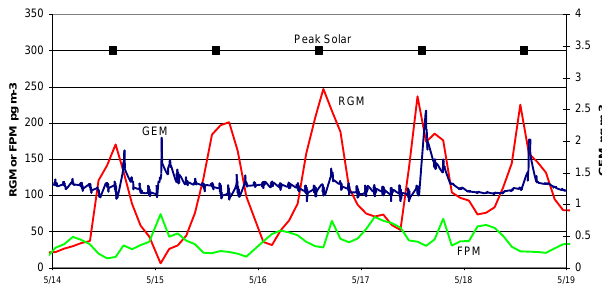
Fig. 4. Reactive gaseous mercury (RGM), fine particulate mercury (FPM), gaseous elemental mercury (GEM), and times of peak solar elevation at Summit, Greenland, 14–19 May 2007.